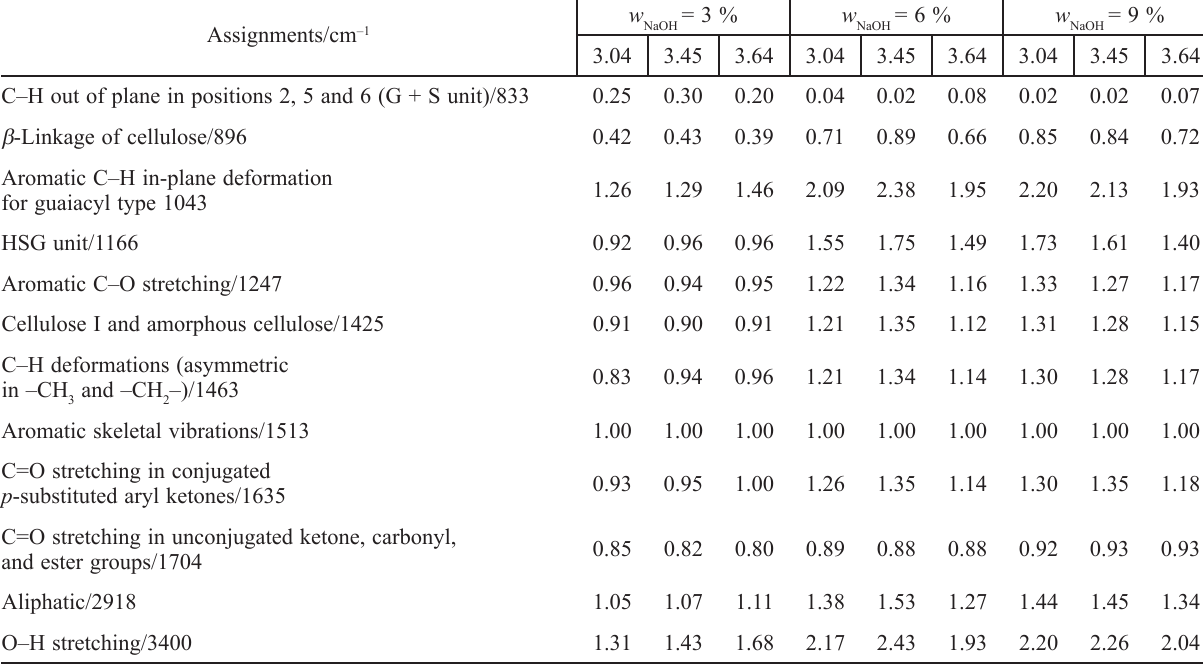
Table 1 and Table 2 show that the different